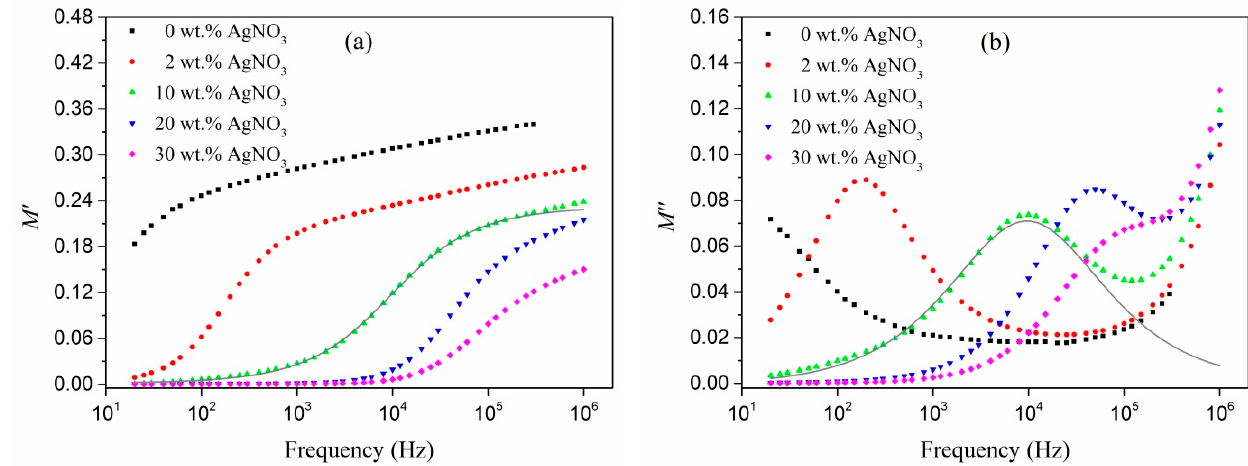
Figure 2. Electrical modulus vs. AC frequency at T = 60 °C: real ( a ) and imaginary ( b ) elements in Ag/PAN nanocomposites made from a mixture with various concentrations of AgNO 3 . The solid lines represent approximating curves according to the Cole–Davidson model.